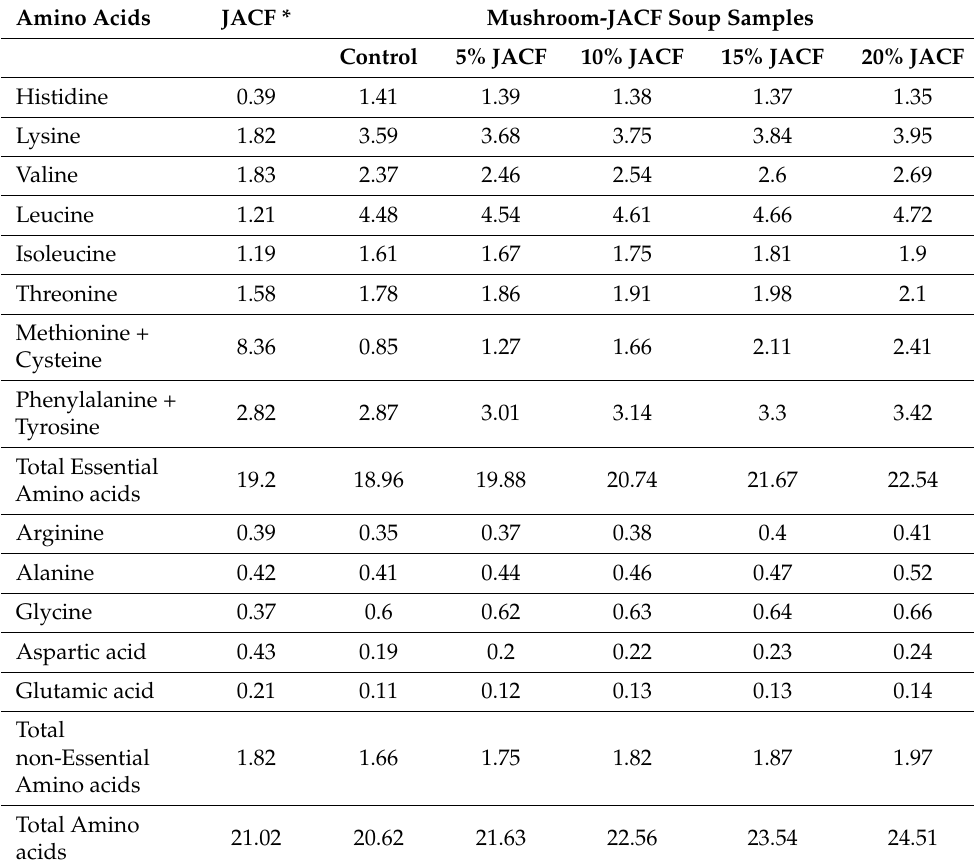
Table 4. Amino acid (g/100 g sample) contents of JACF and mushroom-JACF soup samples. Amino